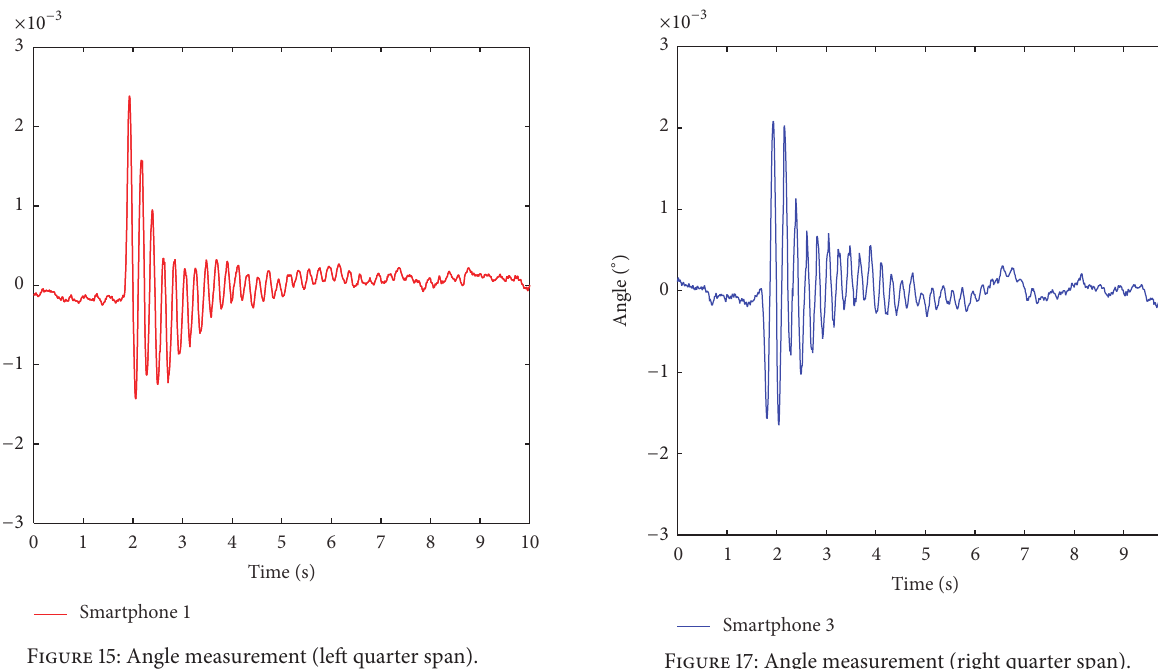
Figure 17: Angle measurement (right quarter span).